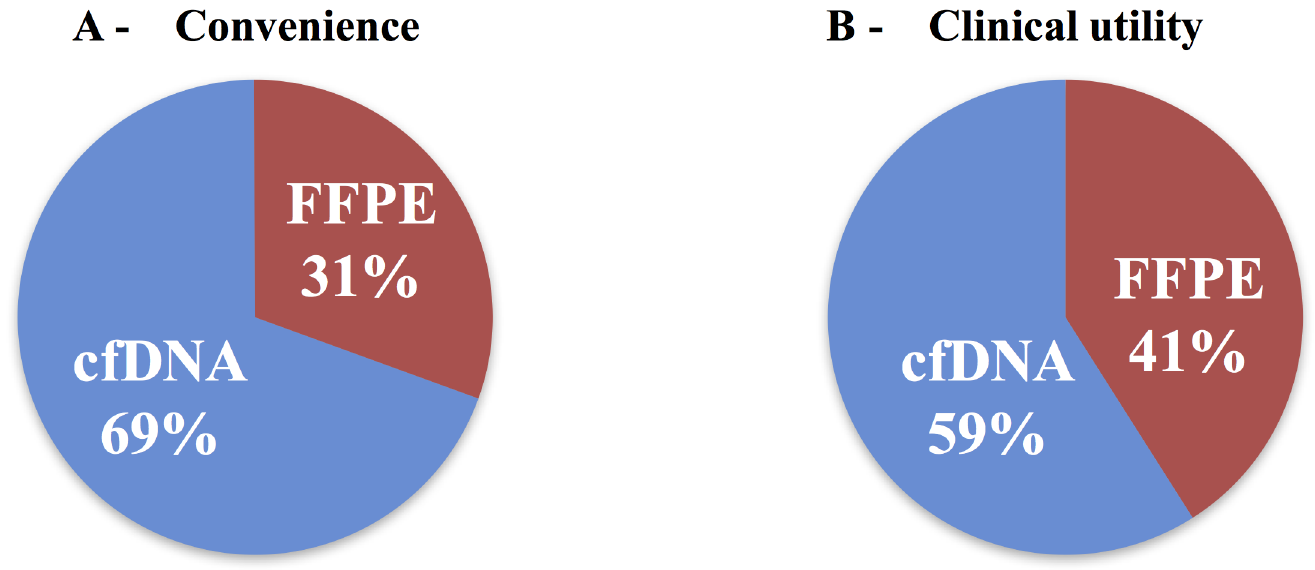
Fig 3. Provider surveryresults. Physicianpreferencefor convenience (A) and clinicalutility (B) accordingto the sample detection method and a stated desire to incorporate sequencing results into clinicaldecisions.FFPE = formalin-fixed, paraffin-embeddedtissue; cfDNA = cell-free DNA.